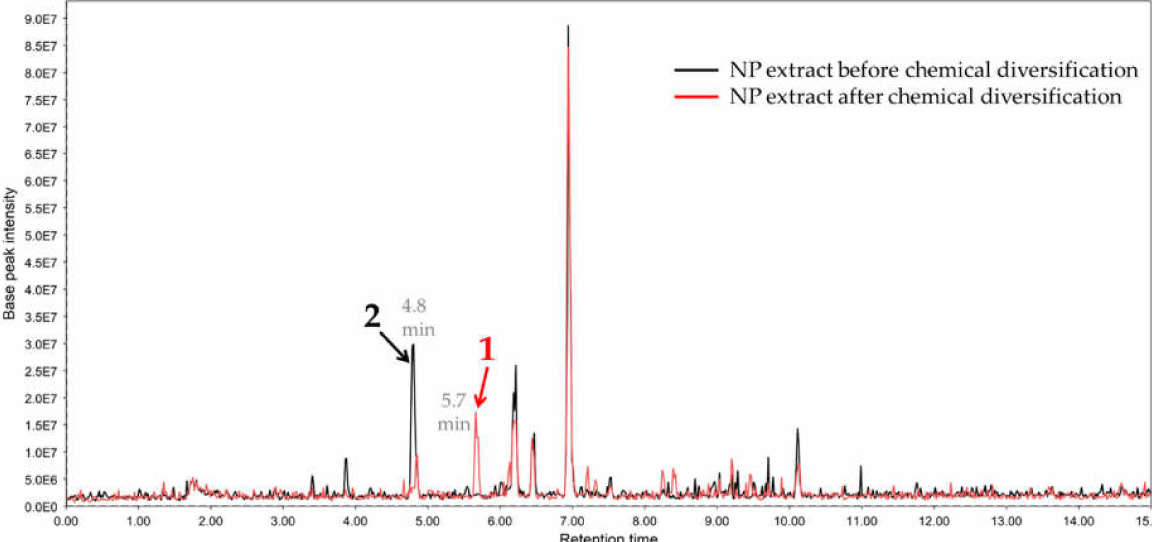
Figure 2. Base peak chromatogram (positive ion mode, reversed-phase liquid chromatography/mass spectrometry (RP-LCMS)) of natural product (NP) extracts before (black line) and after chemical diversification (red line). The retention time is shown on the x-axis, going from 0 to 15 min, and the base peak intensity is shown on the y-axis, going from 0 to 9.0 × 10 7 . Peaks of rac -6- O Et-cylindradine A ( 1 ) at retention time (RT) 5.7 min and (-)-cylindradine A ( 2 ) at RT 4.8 min are pointed out by red and black arrows,